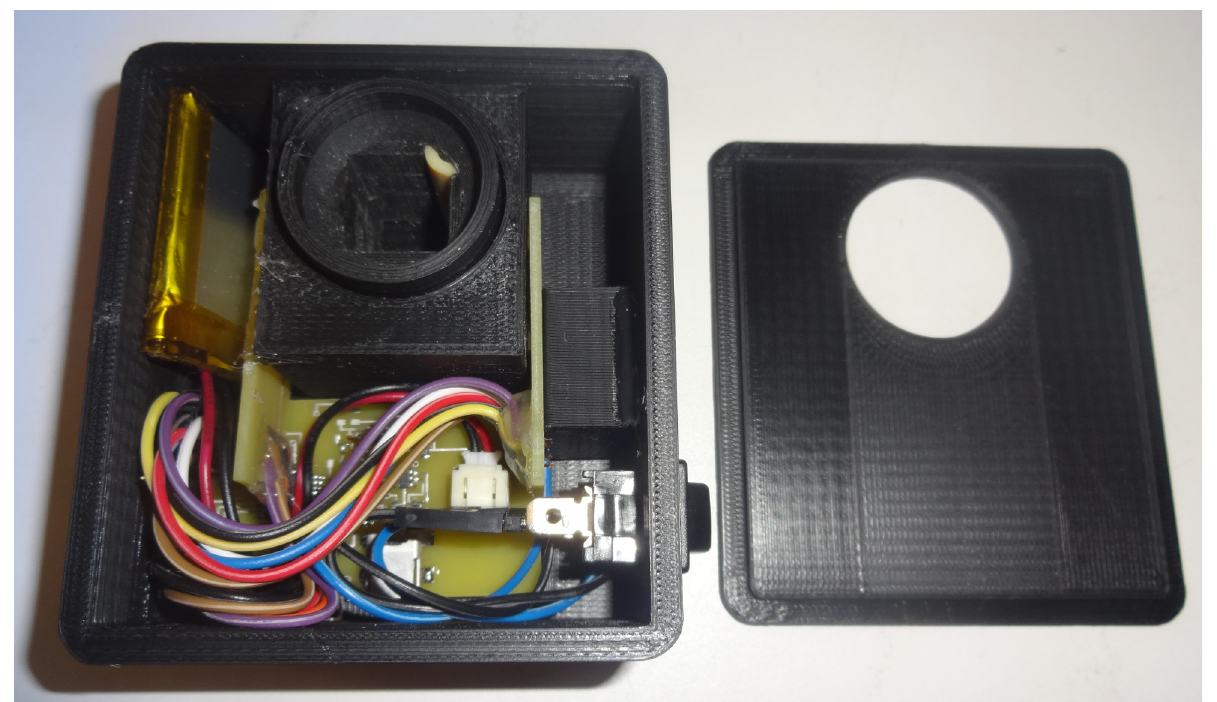
Fig 7. Photometer case with electronics